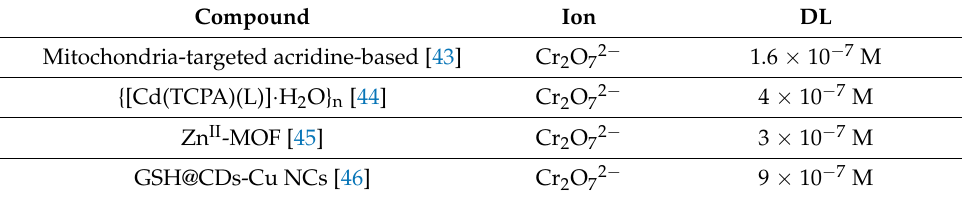
Figure 14. Stern-Volmer plot for titration of SBA-Pr-Is-TAP with different concentrations of Cr 2 O 72 − . Table 3. Comparison of Detection Limits of different fluorescent